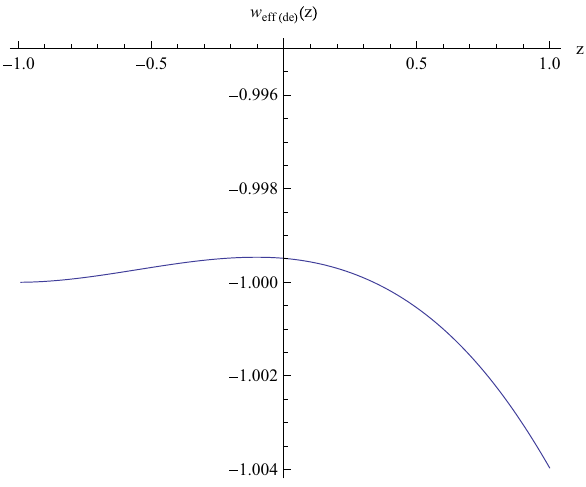
( z ) given in Eq. (5.21) from z = 1 to z = − 1 with ϕ( 1 ) = Fig. 5 w eff de 0 . 1, β( 1 ) = 0 . 01, κ = 1, and (cid:24) m